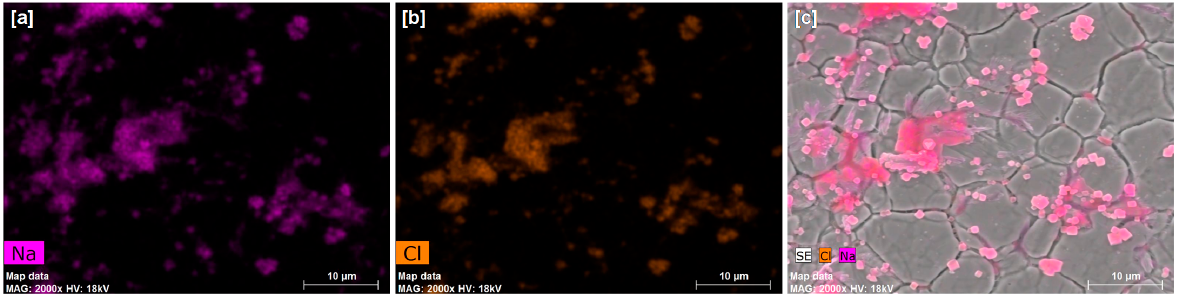
Figure 3. EDX and SEM images ( × 2000) of the uncoated SS after five sanitization cycles with sodium hypochlorite (0.05%): EDX maps of ( a ) sodium and ( b ) chlorine, and ( c ) EDX maps overlapped with the SEM image of the same analyzed